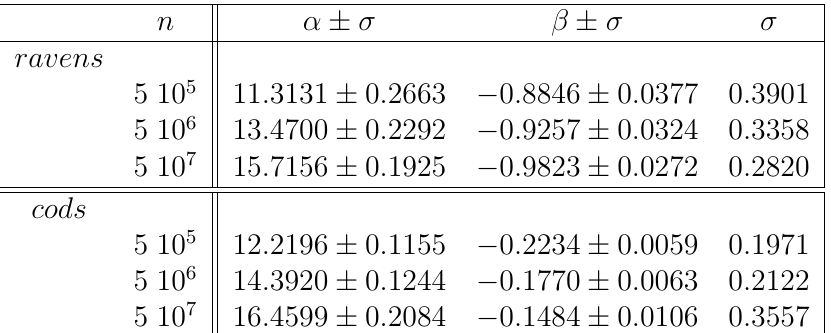
( ν ) : coefficients of the linear n